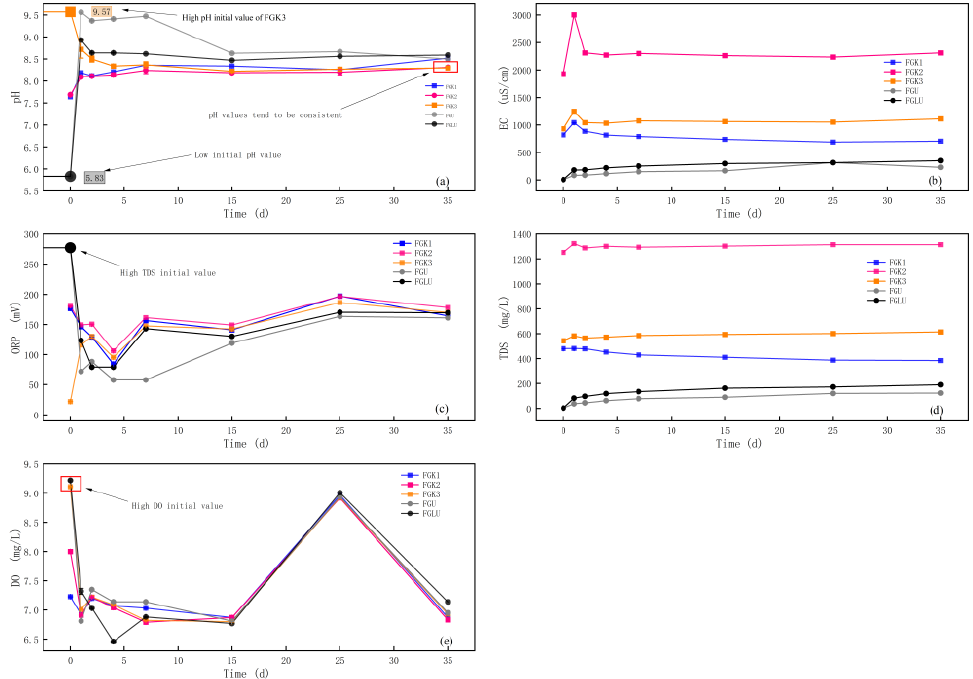
Figure 5. Basic water quality parameters of coal gangue in different immerse solutions over time. (a. Trend graph of pH changes of different immersion solutions over time; b. Trend graph of EC changes of different immersion solutions over time; c. Trend graph of ORP changes of different immersion solutions over time; d. Trend graph of TDS changes of different immersion solutions over time; e. Trend graph of DO changes of different immersion solutions over time)